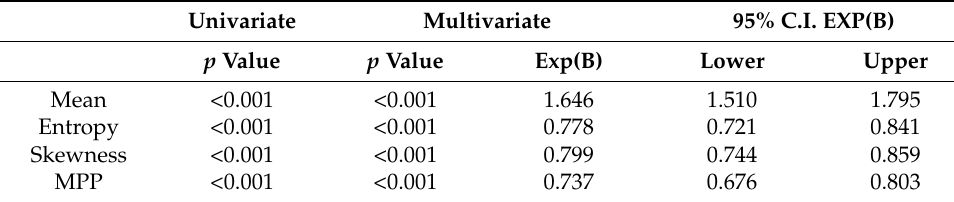
Table 6. Cox regression analysis—radiomic feature association with OS.